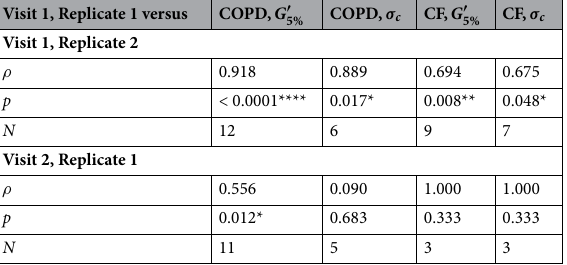
Table 1. Results of Spearman correlation tests between the (Visit 1, Replicate 1), (Visit 1, Replicate 2) and (Visit 2, Replicate 1) cases: Spearman coefficient ρ , p -value and sample size N . * p < 0.05 ; ** p < 0.01 ; **** p < 0.0001